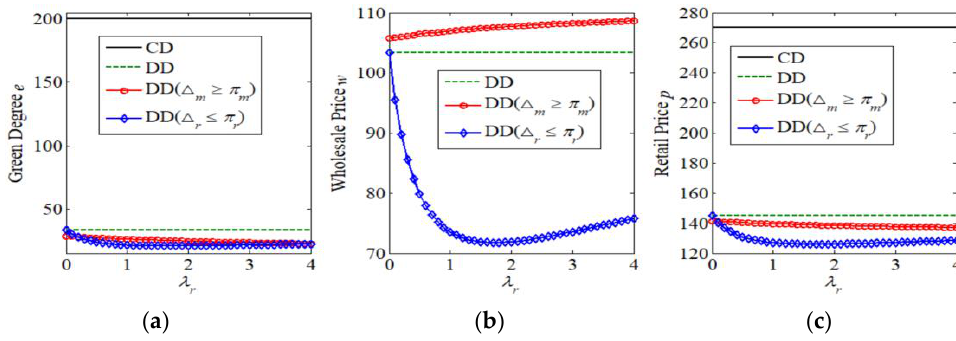
Figure 5. The effects of the retailer’s levels of loss aversion on decision variables.